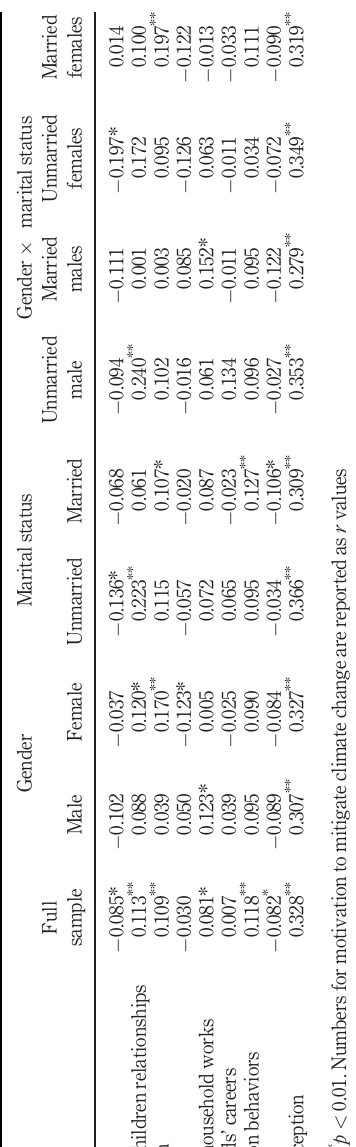
Table 3. Pearson correlation analysis results (dependent variable: Motivation to mitigate climate